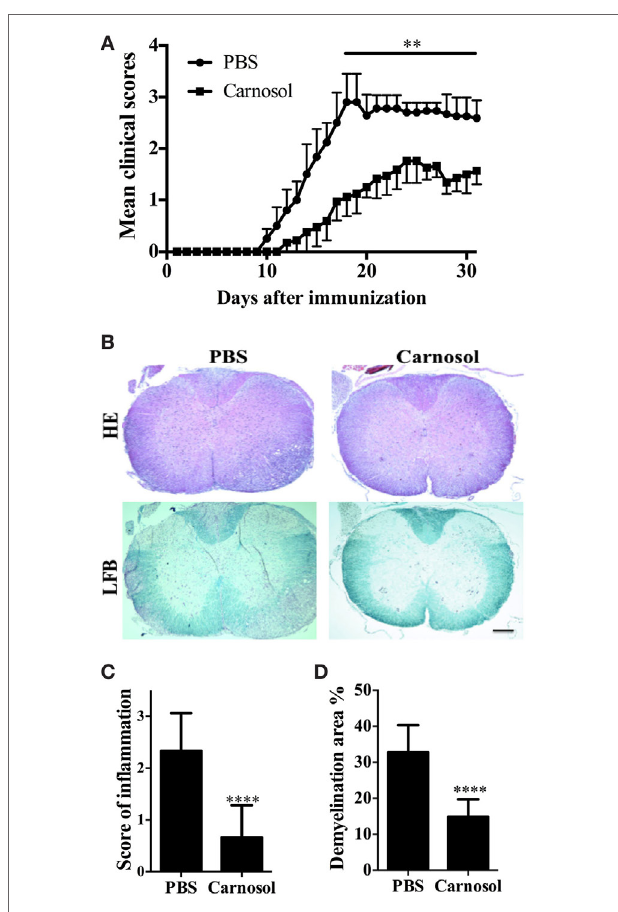
FigUre 1 | Carnosol ameliorated clinical severity of experimental autoimmune encephalomyelitis (EAE). C57BL/6 mice were injected i.p. with PBS or carnosol (50 mg/kg) daily starting on the day of EAE induction, and scored daily following a 0–5 scale (a) . (B) Mice were sacrificed at day 30 p.i. and spinal cords were harvested. Sections at lumbar level (L3) were analyzed by H&E and Luxol fast blue (LFB) (scale bar = 1 mm), and pathology scores of inflammation (c) and percentage of demyelination area (D) were evaluated. Data are mean ± SD ( n = 5 each group). ** p < 0.01 and **** p < 0.0001, determined by two-way ANOVA (a) , or nonparametric test (c,D) . One representative of three independent experiments is